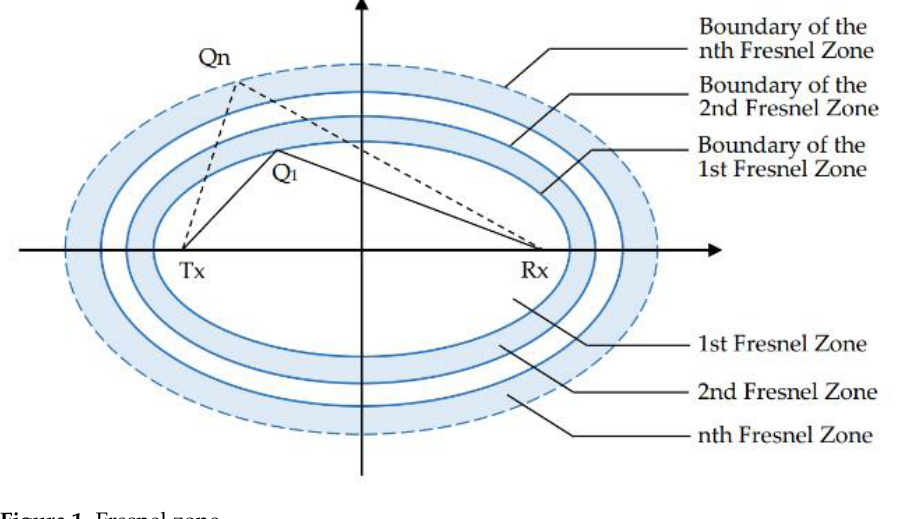
Figure 1. Fresnel Figure 1. Fresnel zone.